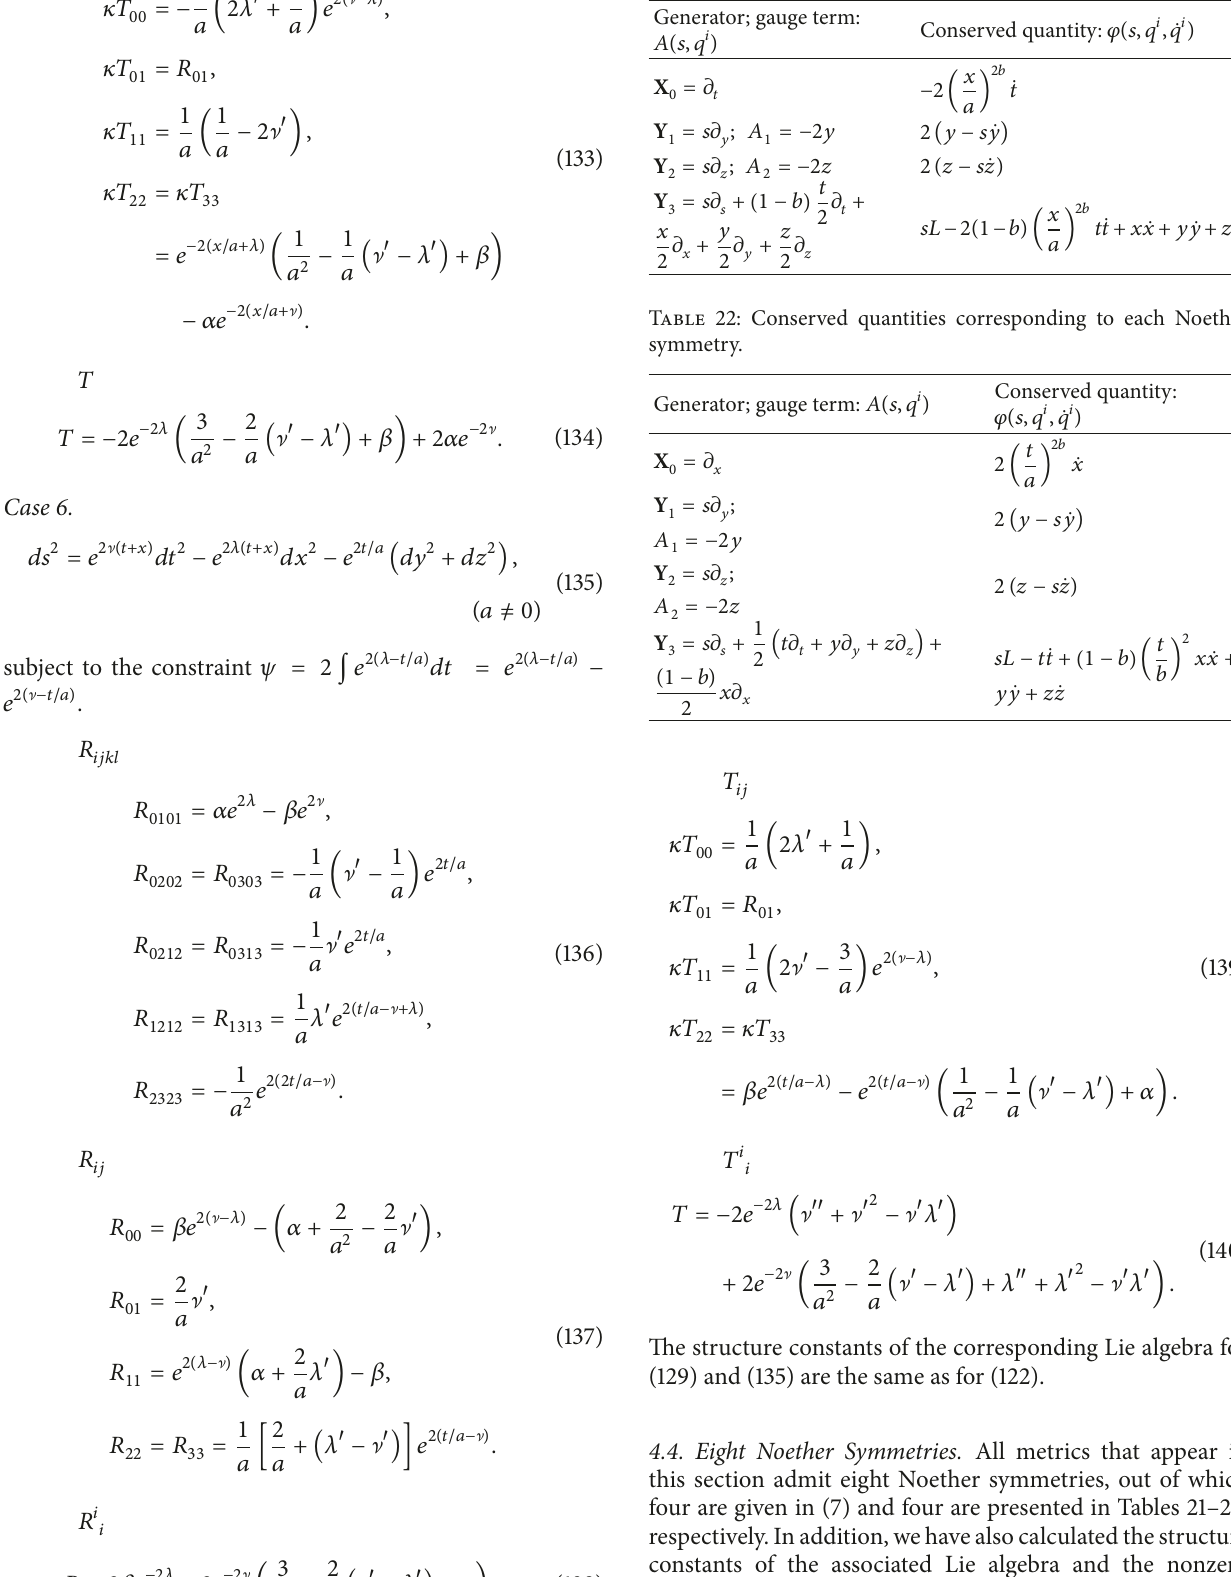
Table 21: Conserved quantities corresponding to each Noether symmetry.